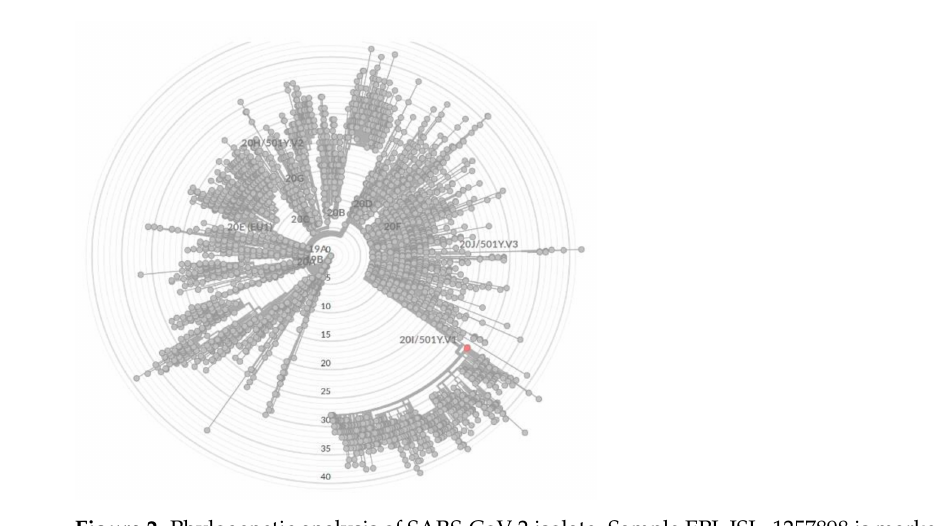
Figure 2. Phylogenetic analysis of SARS-CoV-2 isolate. Sample EPI_ISL_1257898 is marked as red